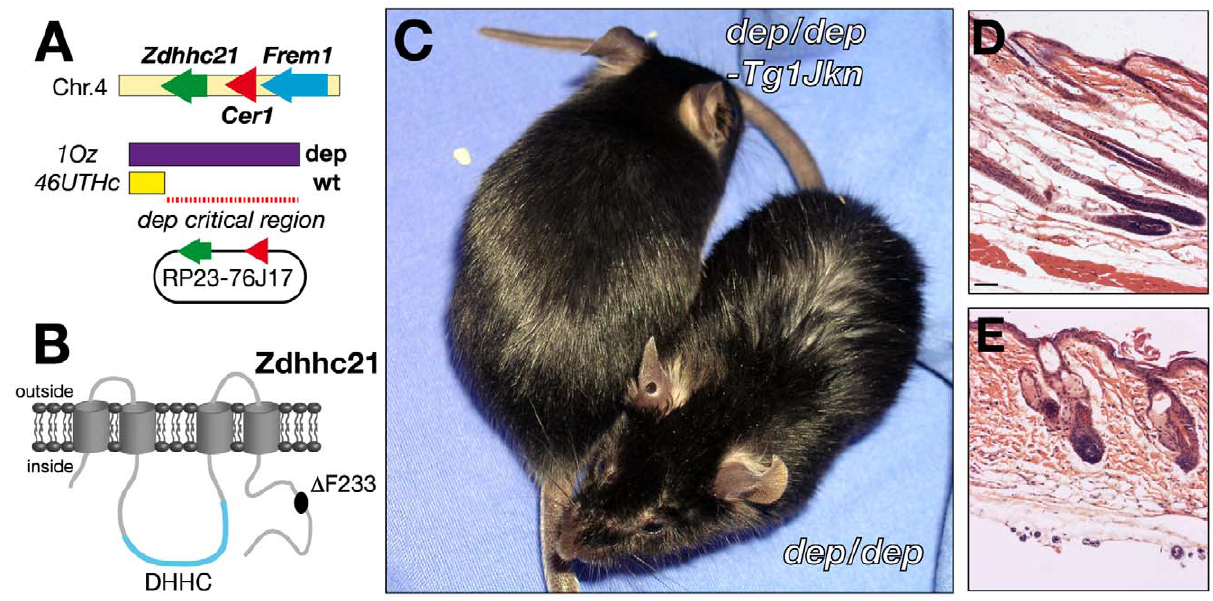
Figure 1. Identification and transgenic rescue of the dep mutation. (A) Mapping the dep interval against the b-del complex. When dep is crossed with the b-IOZ deletion mutant (purple), offspring exhibit the hairloss phenotype. When crossed with the b-46UTHc deletion mutant (yellow), the hairloss phenotype disappears, indicating that the dep mutation lies within the genomic interval between the distal breakpoints of the 2 deletions. (B) Schematic of Zdhhc21 protein with dep C-terminal 3bp deletion resulting in the loss of a single highly conserved residue, phenylalanine (F) at position 233. The cysteine-rich domain containing a conserved DHHC motif is shown in blue on the cytoplasmic side. (C) The BAC clone RP23- 76J17, which harbors the intact genomic sequences of Zdhhc21 and Cer1 successfully rescues the dep phenotype, shown at 6.5 weeks. (D) Transgenic dep mutant skin appears histologically normal and correct timing hair follicle differentiation is also restored. (E) Non-transgenic mutant littermate